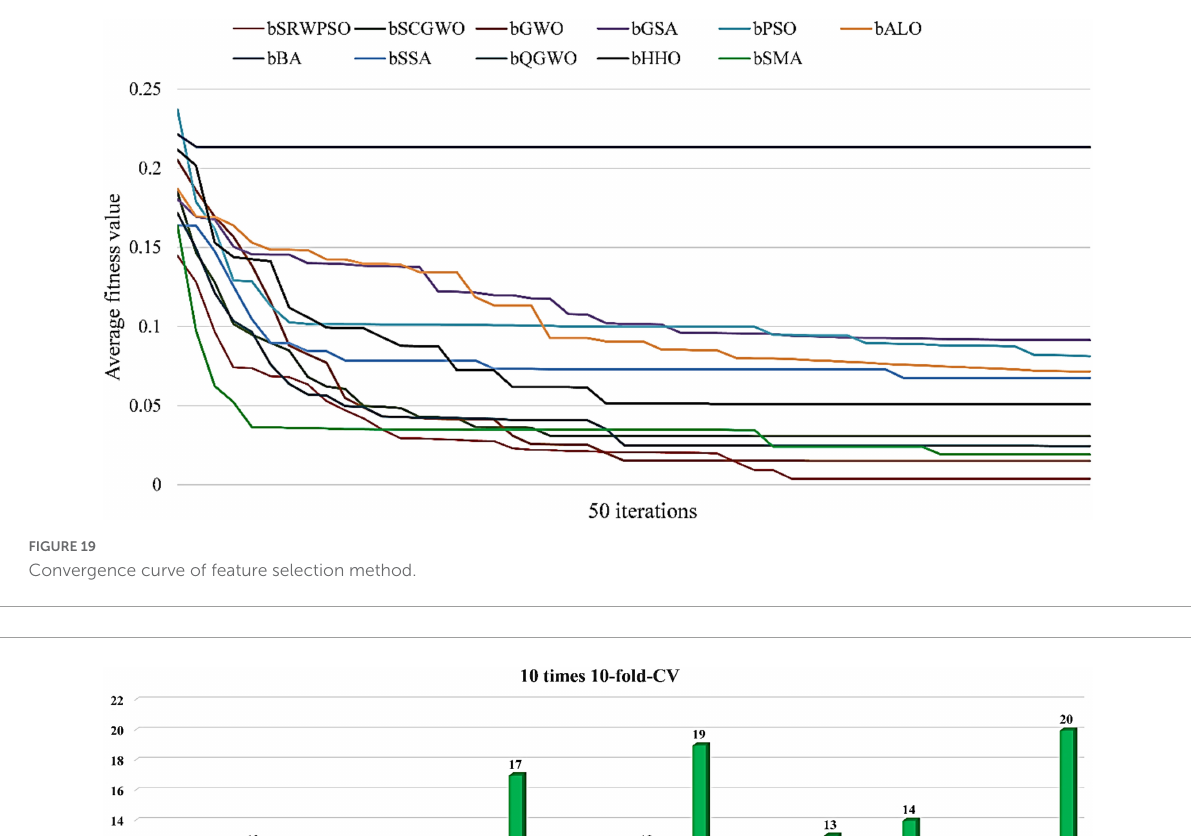
FIGURE19 Convergence curve of feature selection method.